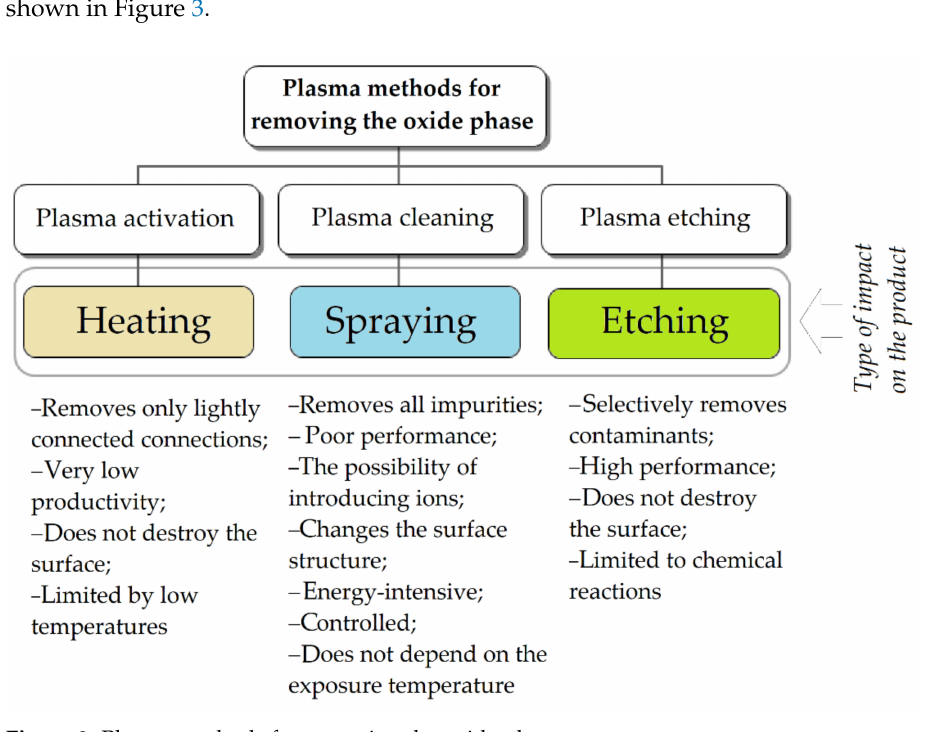
Figure 3. Plasma methods for removing the oxide